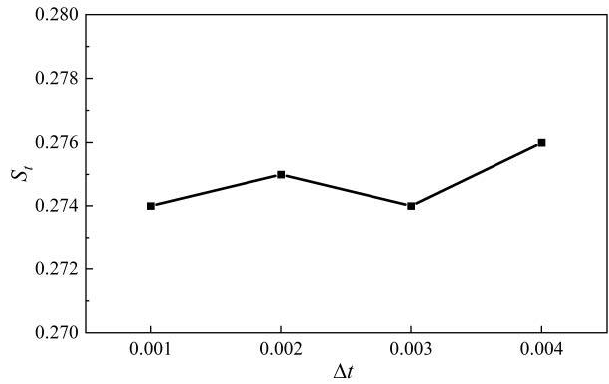
Figure 4. Independence verification of time step Δ t.